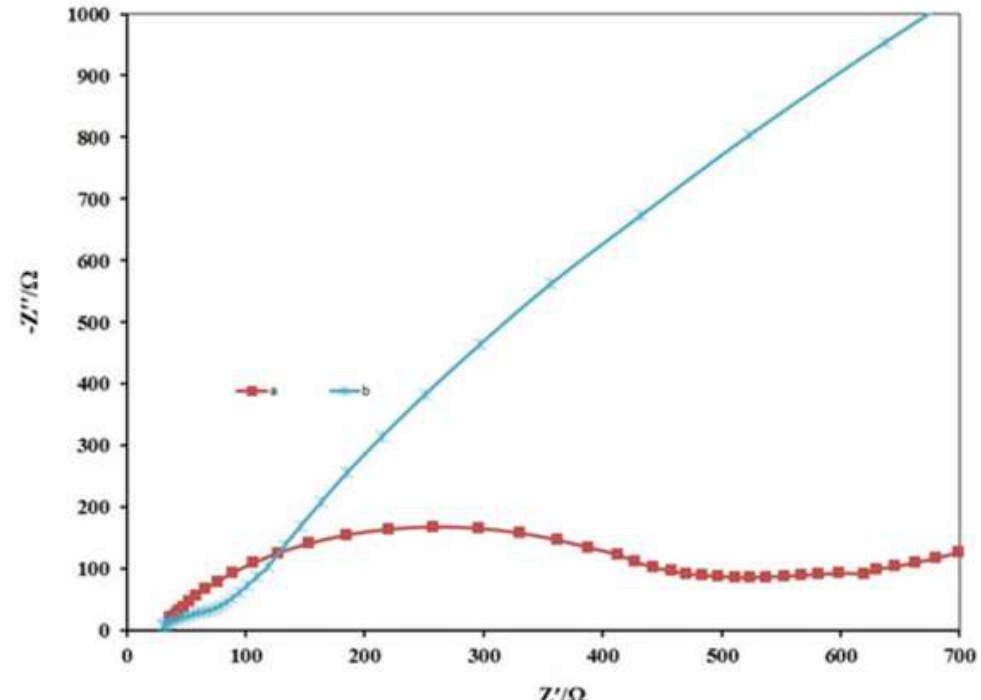
Fig. 4. Nyquist plots for CPE before (a) and after modification with (b) PGA/ TOHS/MWCNTs obtained when the electrodes immersed into solutions of 5mM K3[Fe(CN)6]/K4[Fe(CN)6] and 0.1M KCl